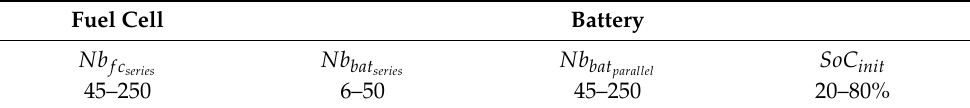
Table 1. Genetic algorithm search